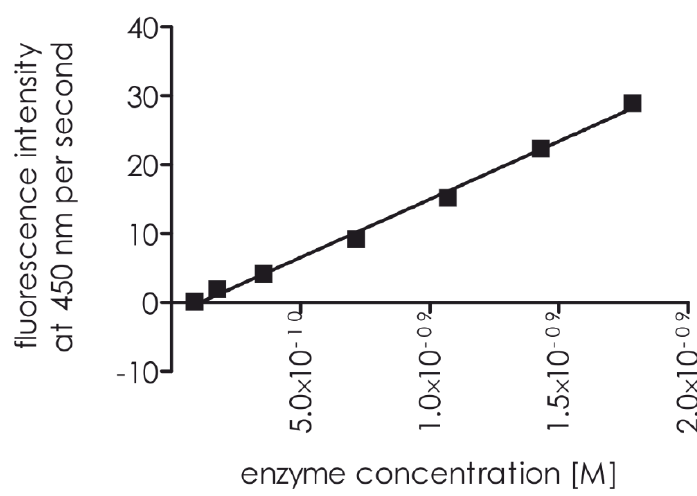
Figure 8. The 20S proteasome assay detection limits. The following 20S proteasome concentrations were analyzed: (1) 2 × 10 − 9 M, (2) 1.5 × 10 − 9 M, (3) 1 × 10 − 9 M, (4) 0.75 × 10 − 9 M, (5) 0.4 × 10 − 9 M, (6) 0.1 × 10 − 9 M, and (7) 0.05 × 10 − 9 M.